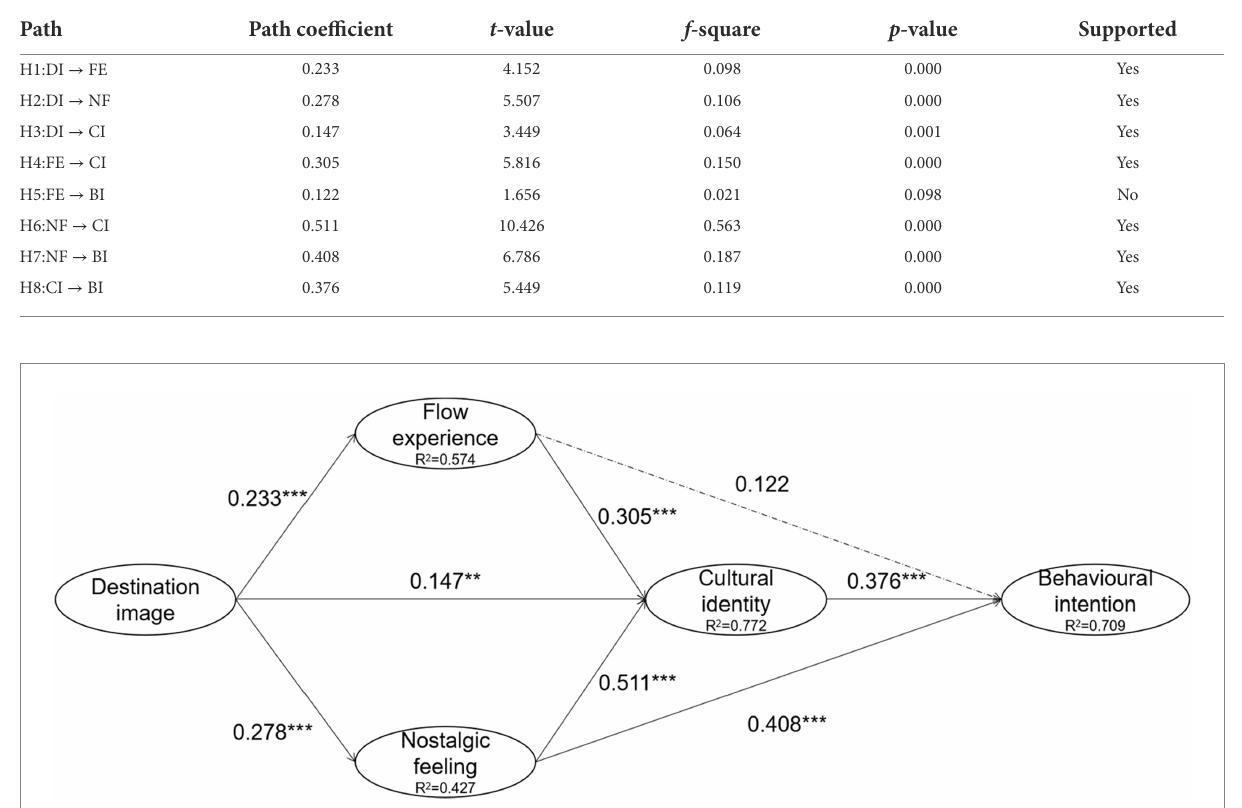
TABLE 3 Path coefficients.